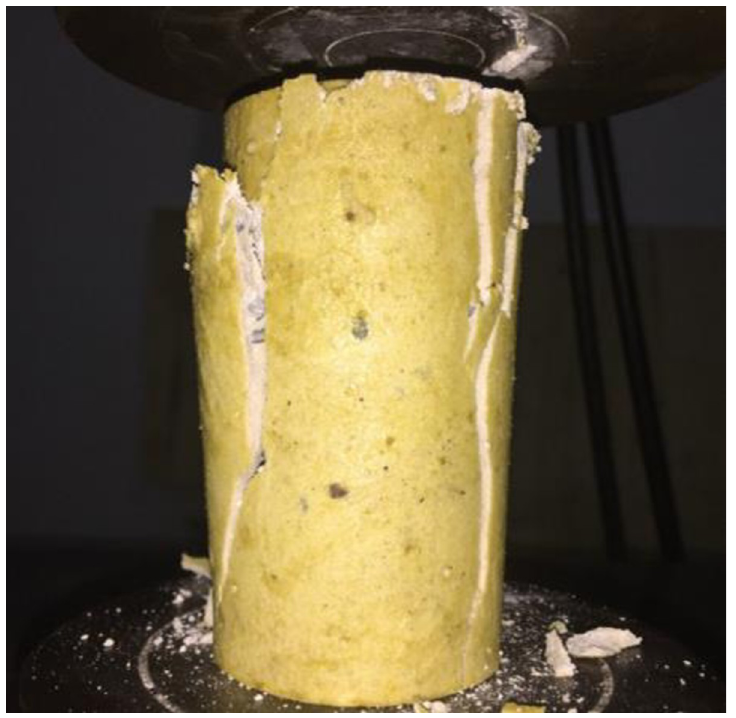
Fig 12. Uniaxial compressive test.